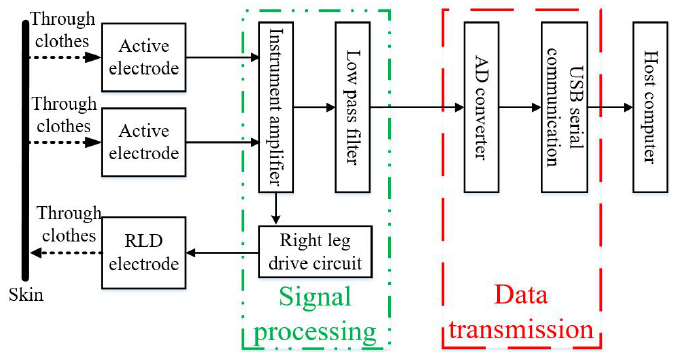
Figure 3. Hardware system block diagram.